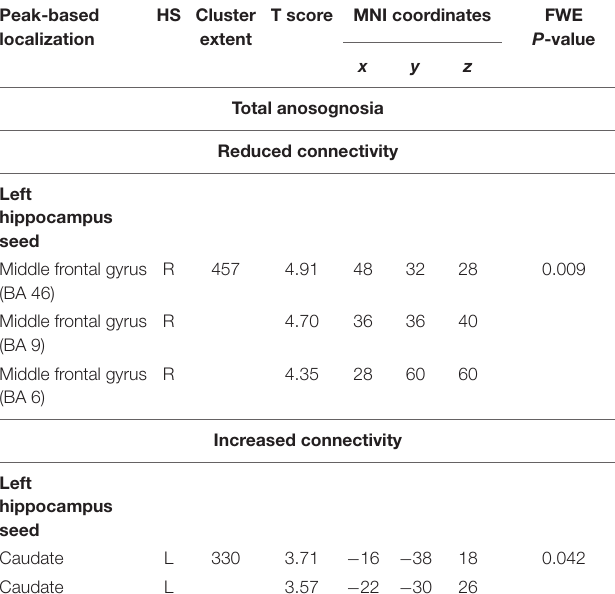
TABLE 5 | Neural correlates of total anosognosia emerging from functional-connectivity patterns obtained via seed-based analysis. Peak-based